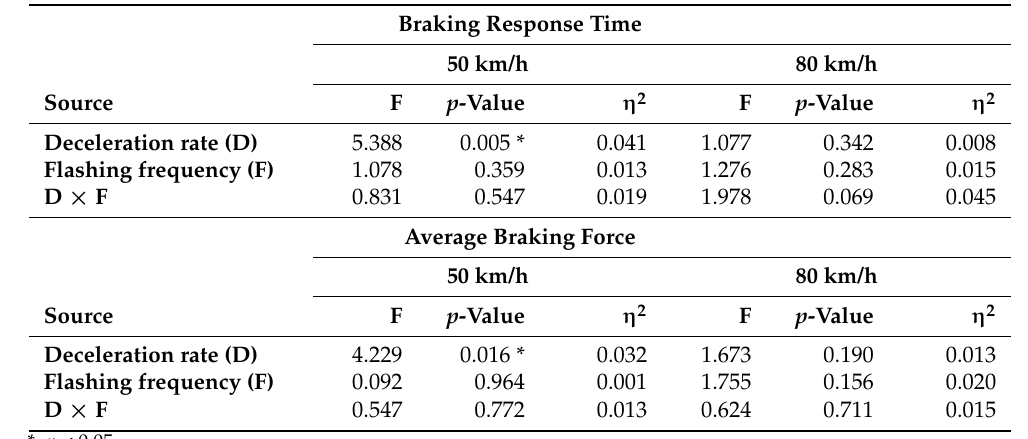
Table 1. ANOVA results: Braking response time and average braking force in the two driving environments.